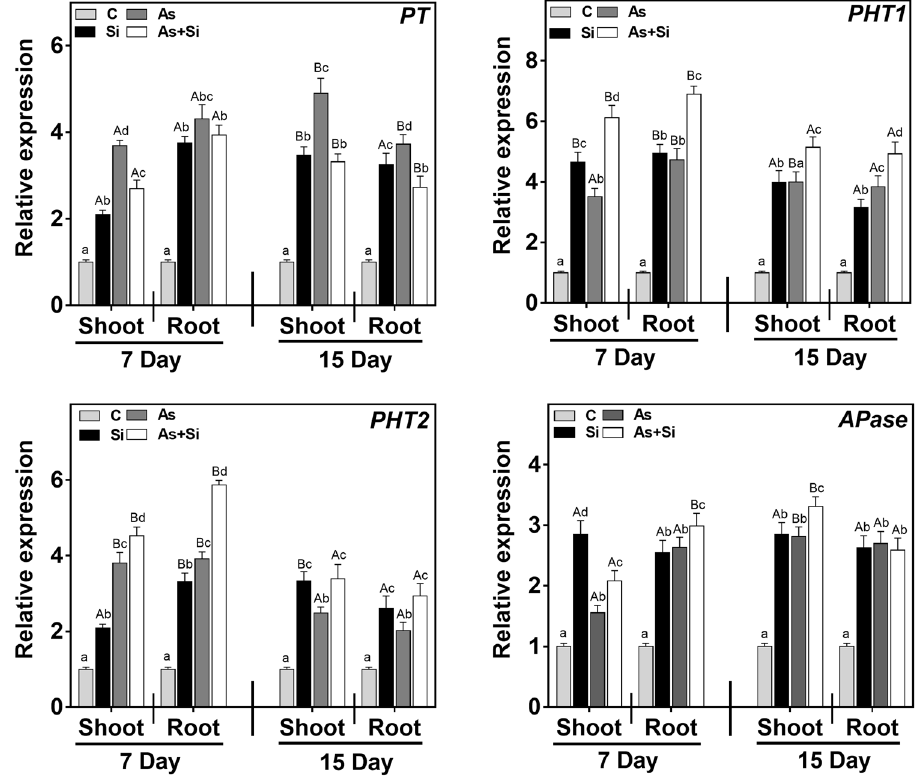
Figure 4. Differential expression of phosphorus absorption and assimilation related genes indicate their role under As and Si exposure in shoot and root of Oryza sativa var. IR64 at 7 and 15 d. Figure shows relative expression profile of phosphate transporter ( PT ), high-affinity phosphate transporter 1 ( PHT1 ), high affinity phosphate transporter 2 ( PHT2 ) and acid phosphatases ( APase ). All values are means of three replicates (n = 3, ± SD) and repeated twice. Different letters indicate the significant mean difference ( p < 0.05) between each treatment. The small latter (i.e. a, b, c and d) indicates the significant difference between treatment in same tissue type while capital latter (i.e. A and B) indicates the significant difference between duration among the same treatment in same tissue type. The endogenous actin gene of rice was used to normalize the genes relative to control.